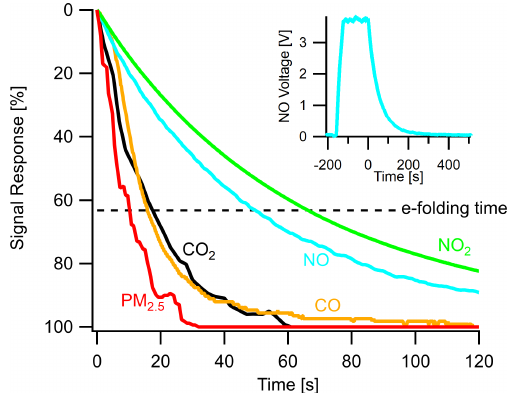
Figure 10. Instrument response times shown as the normalized signal response of various sensors in the stationary monitor to a step change in target pollutant concentration and their respective e - folding times. Insert shows a typical step change of calibration gas and the sensor response. Time zero indicates when the multipollu- tant monitor switched to sampling zero air after reaching a steady- state response to the pollutant. Gas sensor response times vary due to the individual sensors’ diffusive or electrochemical timescales.